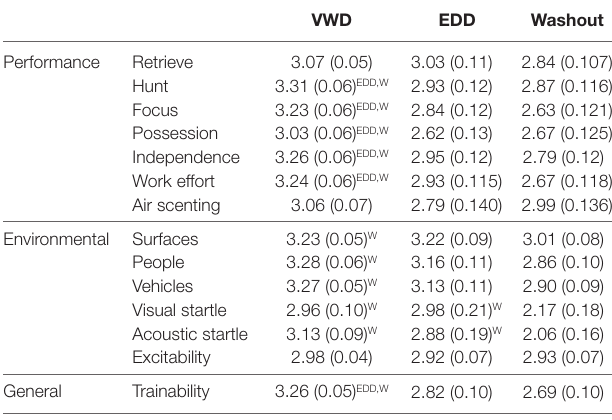
TaBle 2 | Mean (standard error) scores for each group by measure, collapsed across time points. VWD eDD Washout